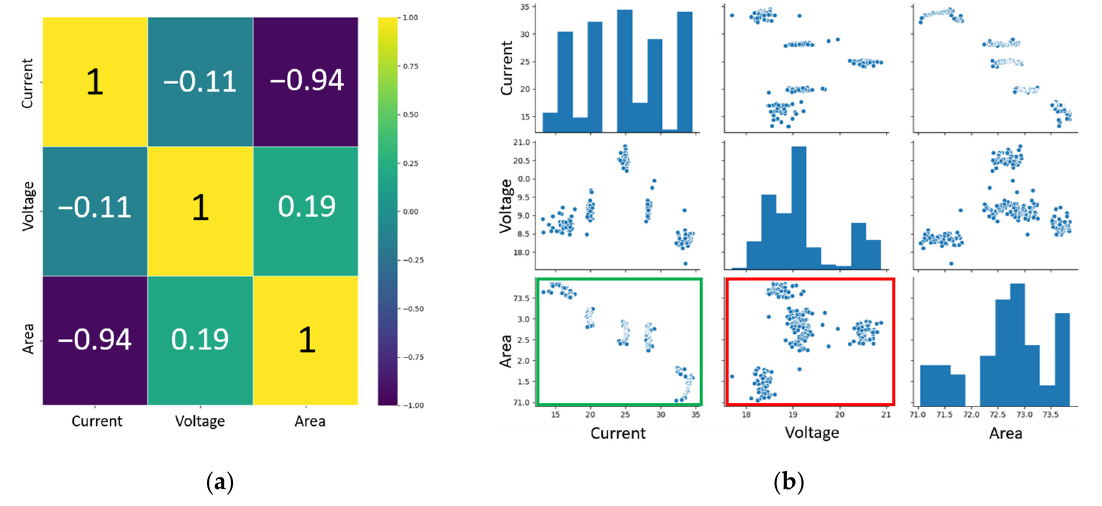
Figure 6. ( a ) Heat map analysis of ECM parameters; ( b ) distribution analysis of ECM parameter. In application, voltage and current are regarded as input data, and the removed area A pair plot was used to analyze the distribution relationship between the two (dimension) is regarded as output to establish a linear regression model, as presented in Figure 7; to estimate the processing quality, regression analysis is used to determine the relationship between the reaction variable Y and the explanatory variables current and voltage.